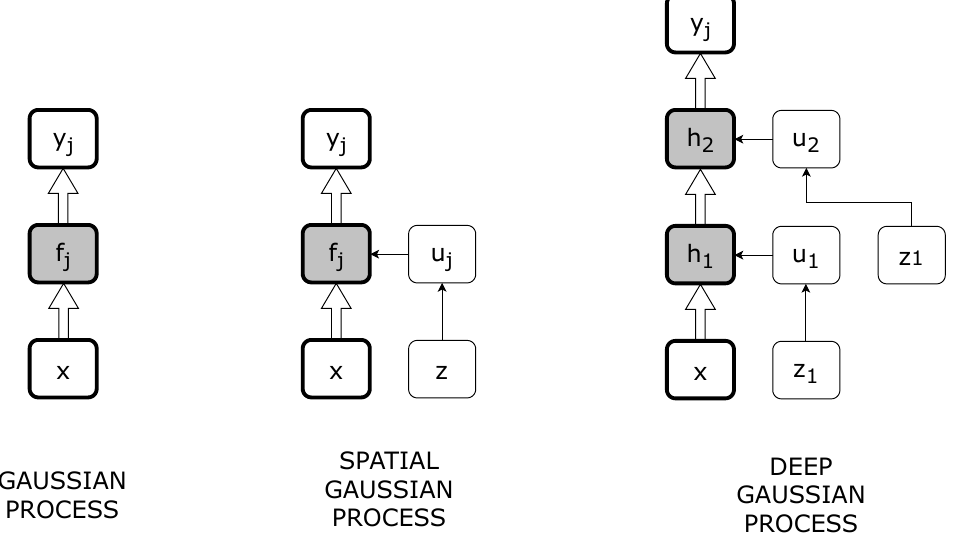
Figure 1. Particular problem of predicting battery parameters such as State of Health and Remaining Useful Life was not solved but is a simple use of GP. In order to receive desirable solution, the authors enhanced GP into Deep GP (DGP), which uses principals of spatial GP (SGP). The figure shows the major differences in such approaches. To create an SGP, a standard GP dataset is augmented with pseudo-inputs z and the outputs u associated with them. DGP uses the SGP idea and stacks layers of outputs and pseudo-inputs on each other, which creates hidden layers h . This solves problems of accuracy dependence on the locations of data points and computational complexity [28].